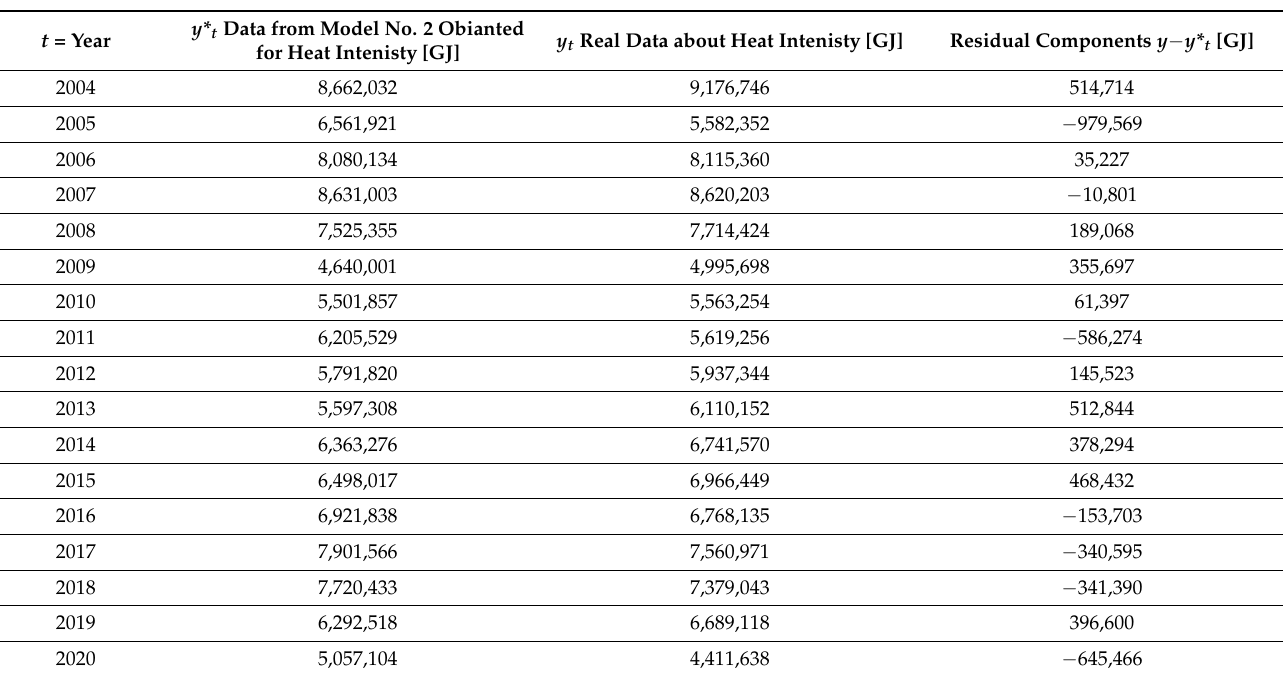
Table 7. Comparison of heat intensity in the Polish steel industry based on the real data and data from model No. 2.